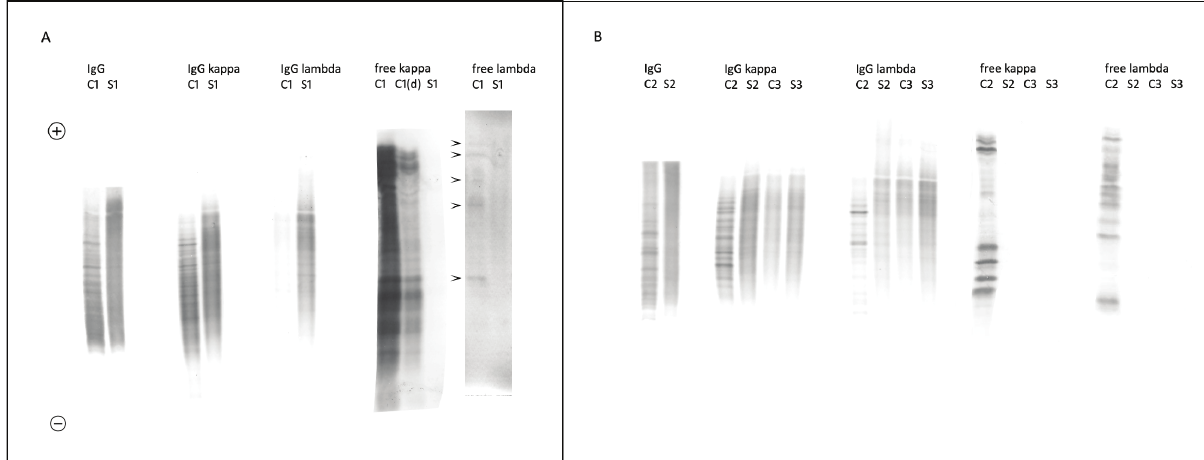
Fig. 4. Two patterns of CSF-restricted light chain distribution in MS patients. C, cerebrospinal fluid; S, serum; (d), CSF diluted 1/5. Samples 1 and 2 (positive) originate from MS patients, whereas